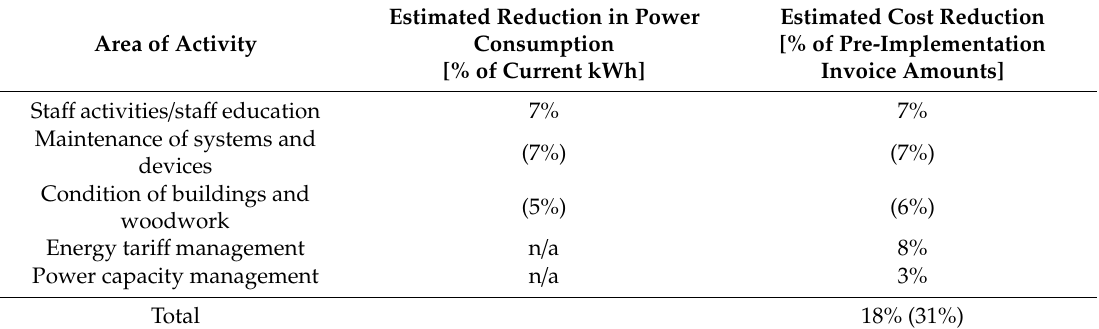
Table 2. Post-pilot estimates regarding the scale of savings in the long